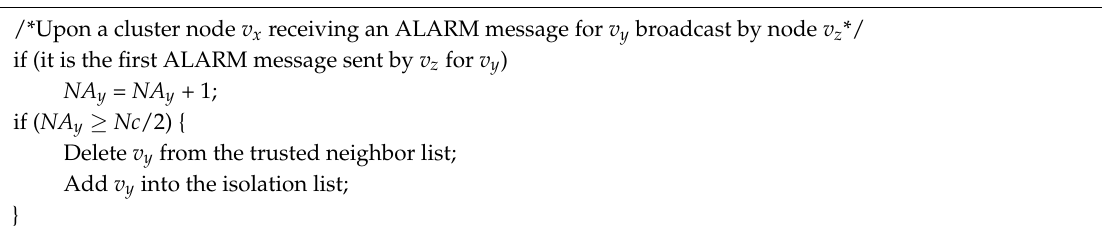
Algorithm 2. Processing of ALARM Message